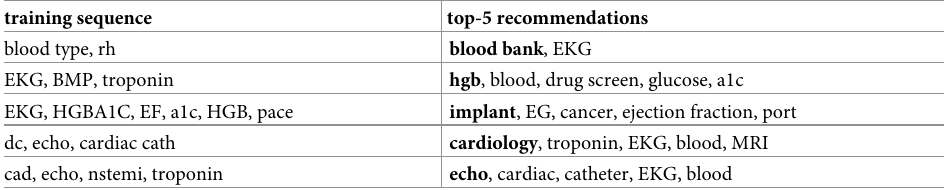
Table 5. Top-5 recommendation examples generated by DmCF-ypCF with simP2Y